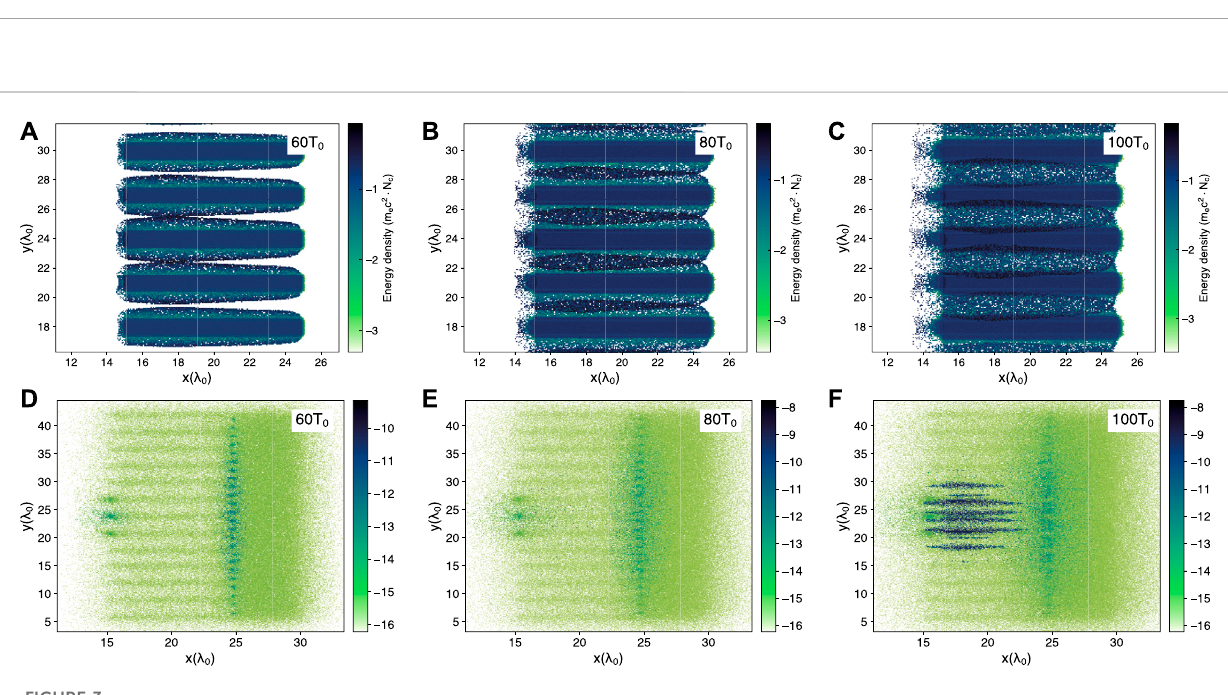
FIGURE 3 The deuterons energy density of the multi-channel target at (A) 60T 0 , (B) 80T 0 and (C) 100T 0 . The neutron number density of the multi-channel target at (D) 60T 0 , (E) 80T 0 and (F) 100T 0